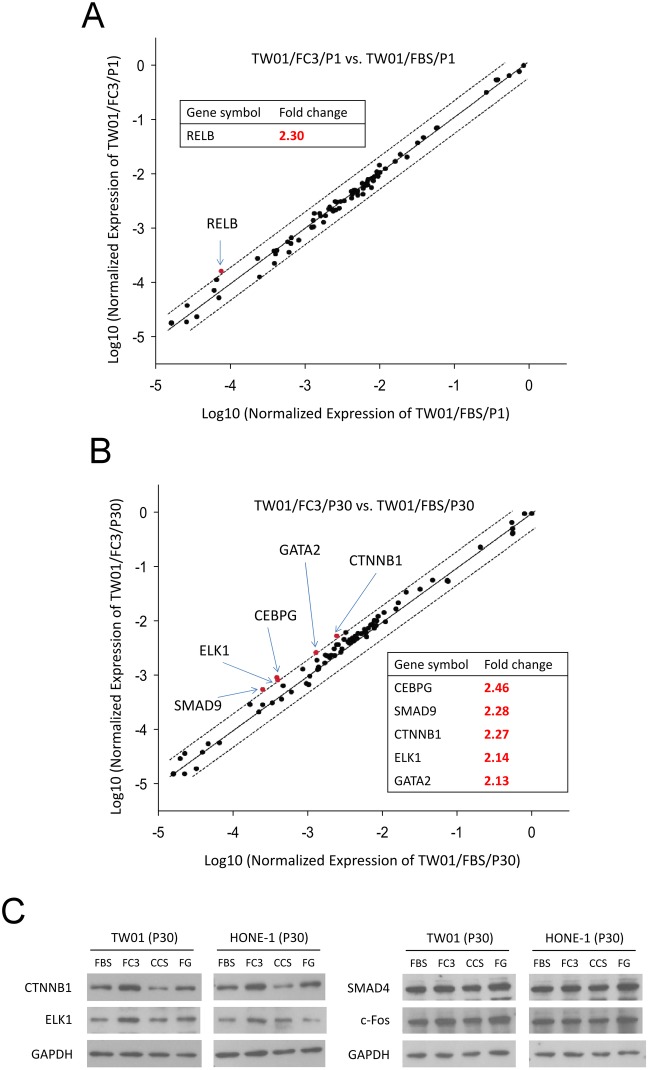
The transcription factor profile of TW01 cells cultured in FBS and FC3.(A) The scatter plots of the transcription factor profile in TW01 P1 cells. (B) The scatter plots of the transcription factor profile in TW01 P30 cells. The central line indicates unchanged gene expression; dotted lines represent the two-fold regulation cut-off. Genes with fold change > 2 indicated. (C) Western blot analysis of CTNNB1, ELK1, SMAD4, and c-Fos expression in TW01 and HONE-1 P30 cells cultured in different sera. GAPDH is detected as a loading control.